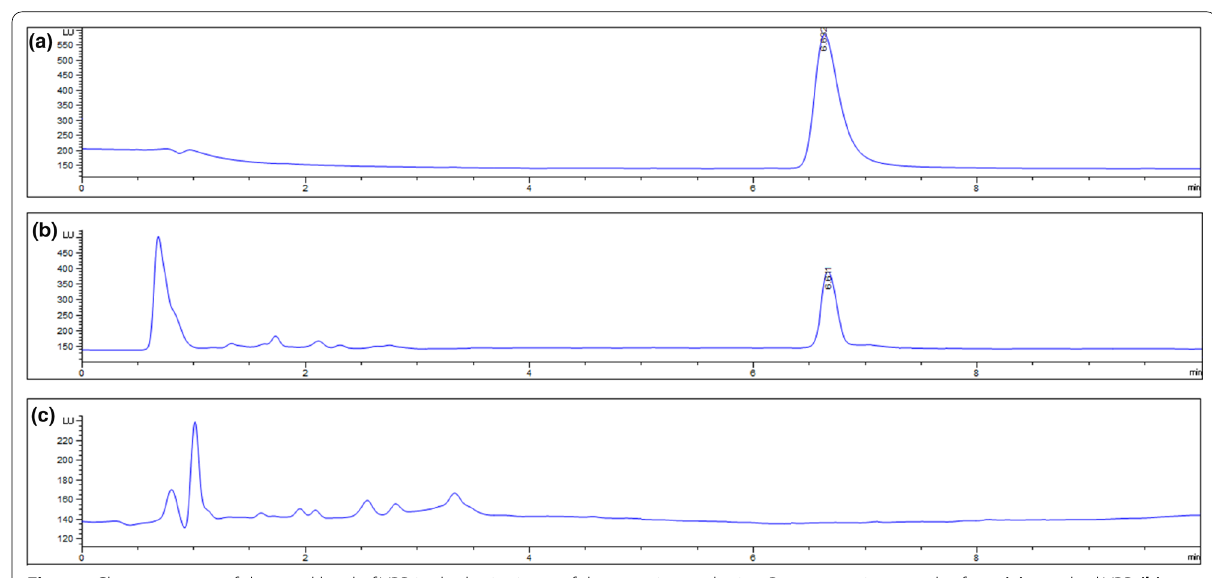
Fig. 11 Chromatogram of detected level of VRP in the brain tissue of the experimental mice. Representative samples from (a) standard VRP, (b) morning and evening VRP, and (c) normal control;